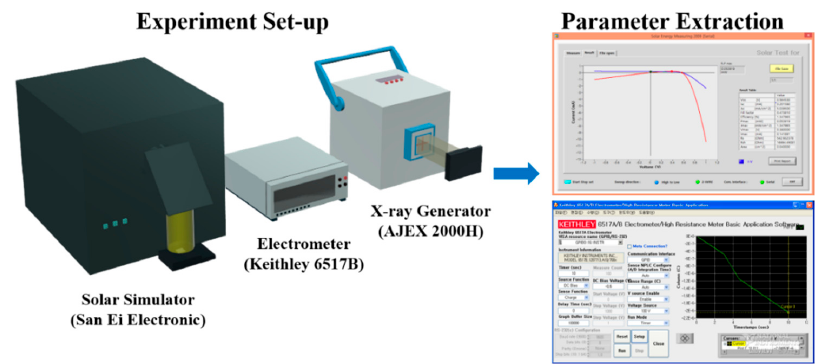
Figure 3. Experimental set-up for measuring the solar parameters (J sc , PCE, and R s ) and X-ray parameters (CCD, DCD, and sensitivity).